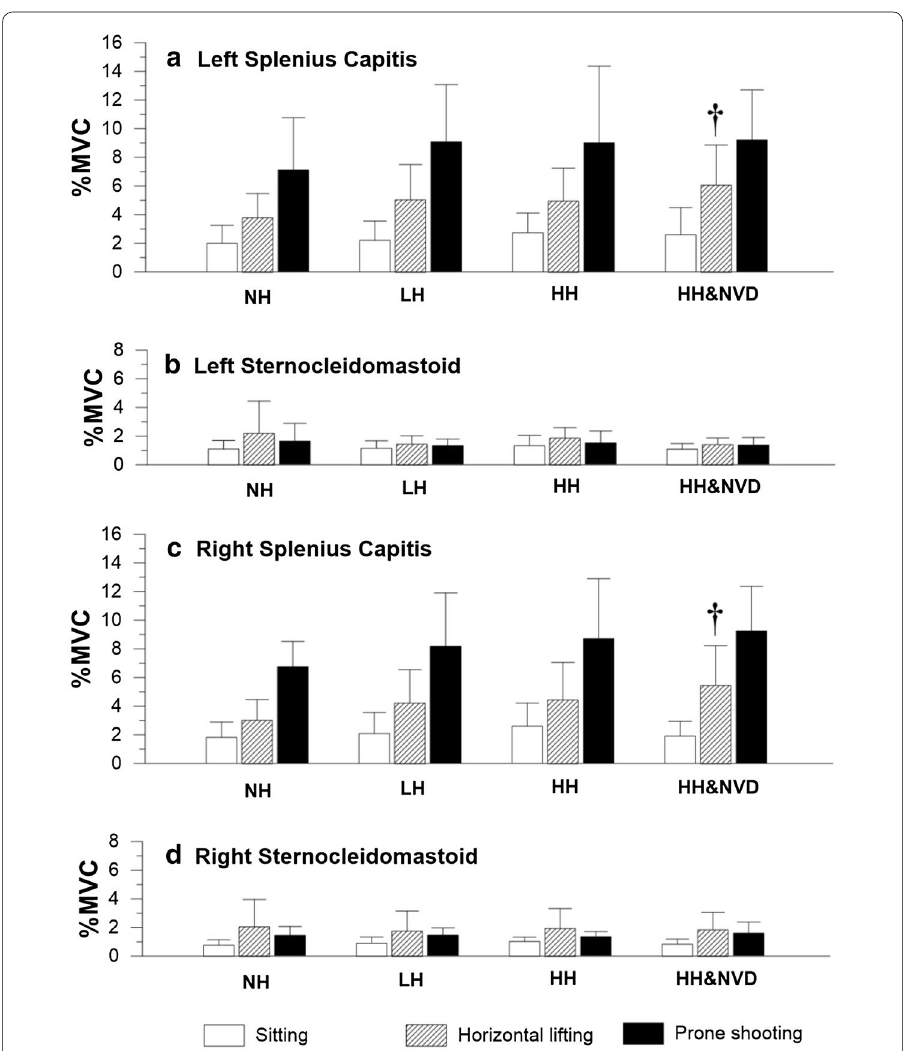
Fig. 2 Effect of total helmet weight on the muscle strain of the four neck muscles during sitting, horizontal lifting, and prone shooting described as changes in %MVC ( N for 5 min during each posture. NH helmet with a night vision device (total weight Friedman test used for identifying the group differences with a Wilcoxon test as a post-hoc